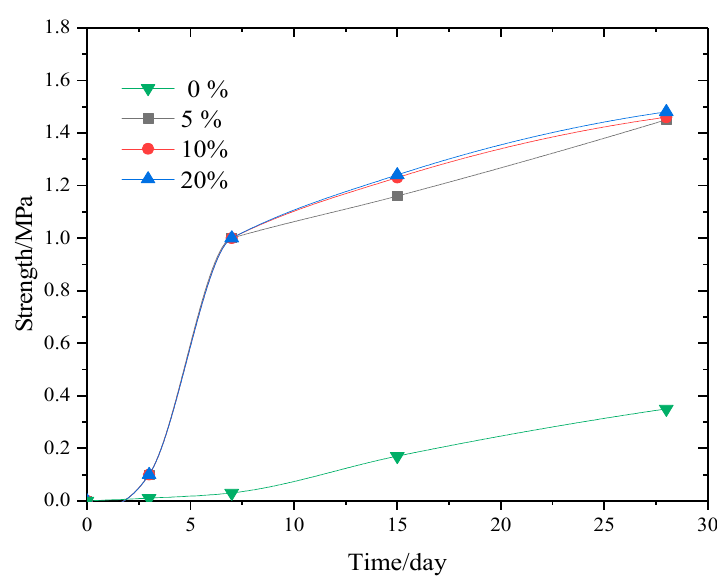
Figure 6. Influence of cement content on the strength of the filling material.